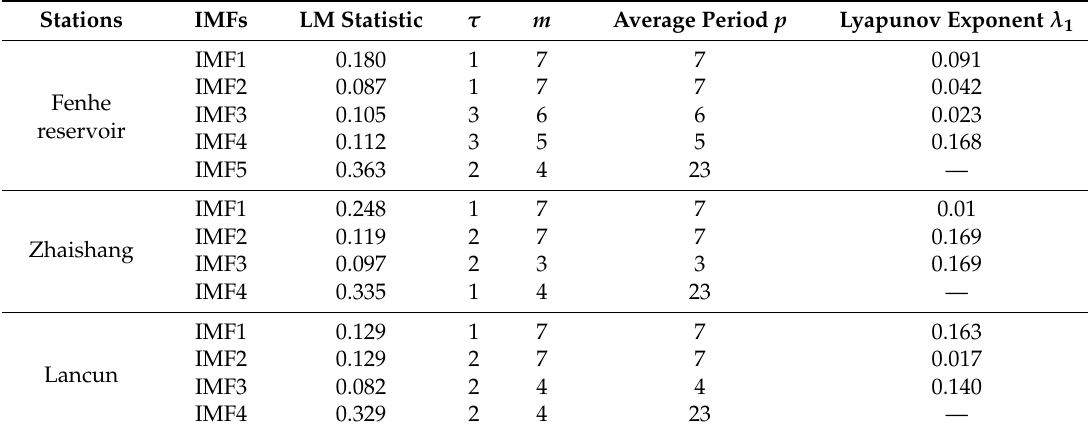
Table 3. LM statistic, delay time τ , embedding dimension m , average period p , and Lyapunov exponent λ 1 of IMFs for the three stations.